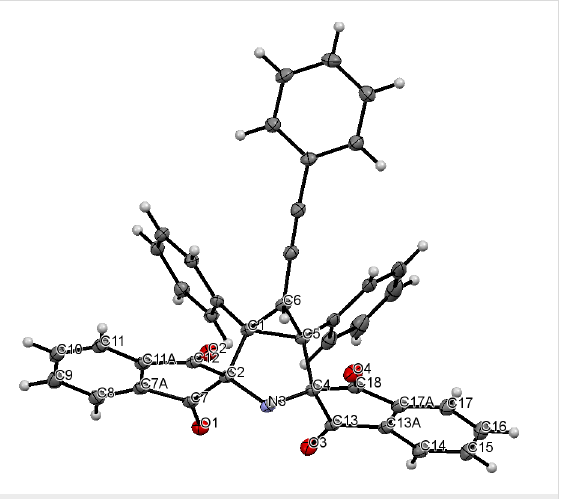
Figure 1: ORTEP representation of the molecular structure of 3e